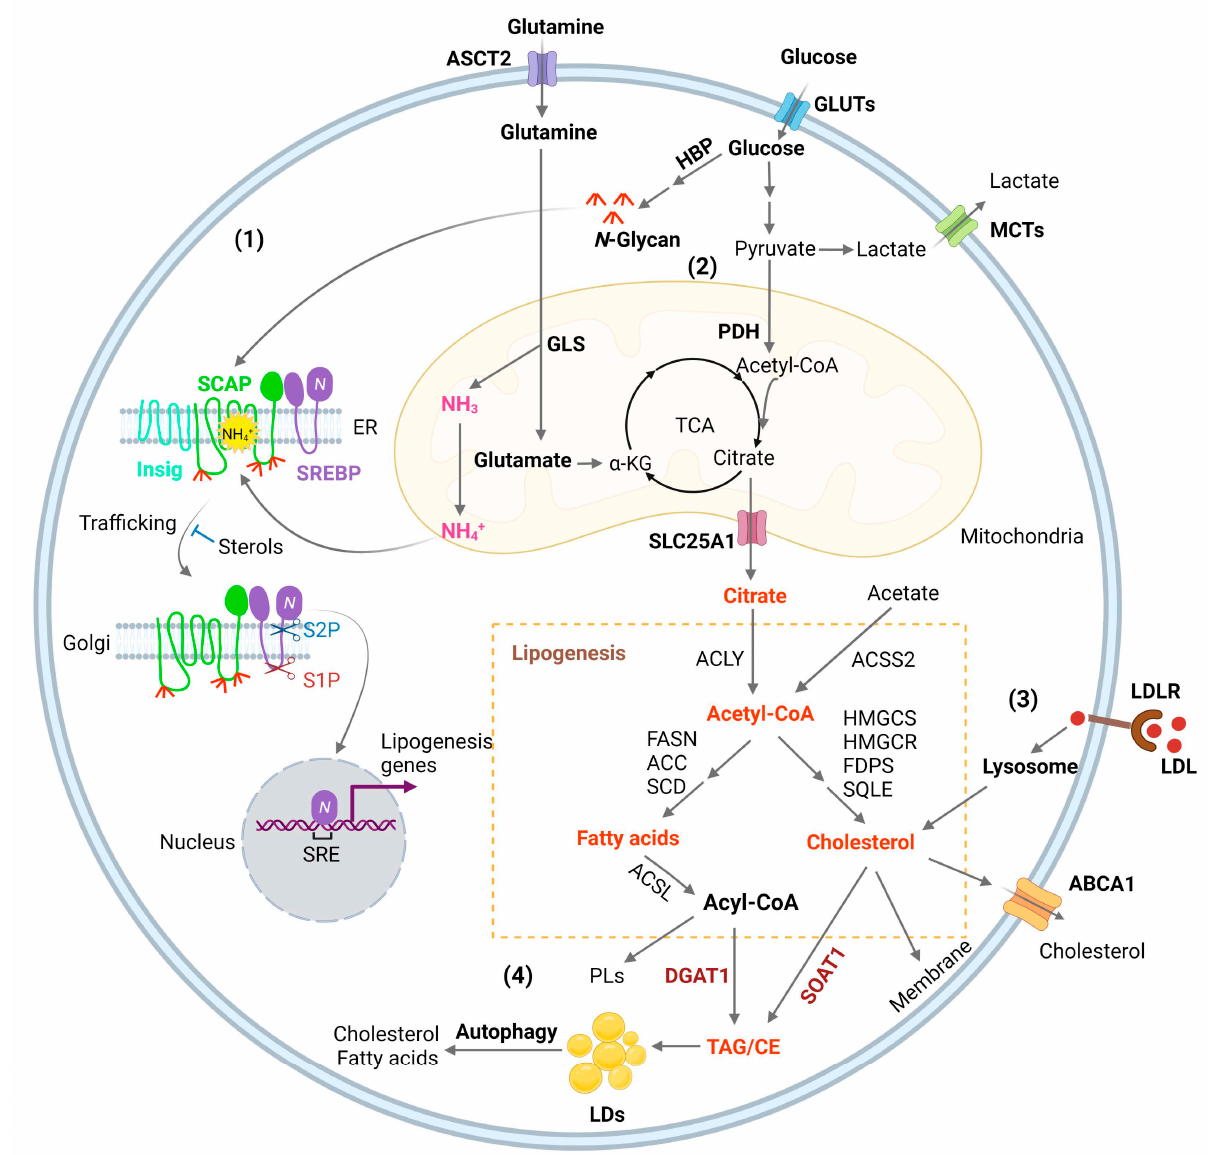
Figure 1. Lipid metabolism reprogramming in cancer cells. ( 1 ) Combined elevation of glucose and glutamine consumption promotes lipogenesis by activating the SREBP/SCAP pathway. Glucose produces N-glycans through HBP (Hexosamine Biosynthesis Pathway), which stabilizes SCAP (SREBP-cleavage activating protein) through N-linked glycosylation of its luminal loops (1 and 7). Glutamine enters the mitochondria and ammonia (NH3) is released by GLS (glutaminase). NH3 is protonated and converted to NH4+, which directly binds to the aspartate D428 and Serine S326/330 in the core of the SCAP transmembrane domains, forming stable hydrogen bonds. This binding triggers a dramatic conformation change in SCAP, leading to its dissociation from Insig (insulin-induced gene), an endoplasmic reticulum (ER)-resident protein. Subsequently, SCAP escorts SREBP (sterol regulatory element-binding protein) to the Golgi, where it is cleaved by two enzymes S1P (site 1 protease) and S2P (site 2 protease) to release its active N-terminal fragment. Finally, the N-terminal domain goes into the nucleus, binds to the SRE (sterol regulatory element) motif located in the promoters of gene involved in lipogenesis to activate their transcription and promote de novo lipid synthesis and tumor growth. ( 2 ) Glucose is the main source for lipid synthesis. Glucose via glycolysis breaks down into pyruvate, which enters the mitochondria and is converted to acetyl-CoA by